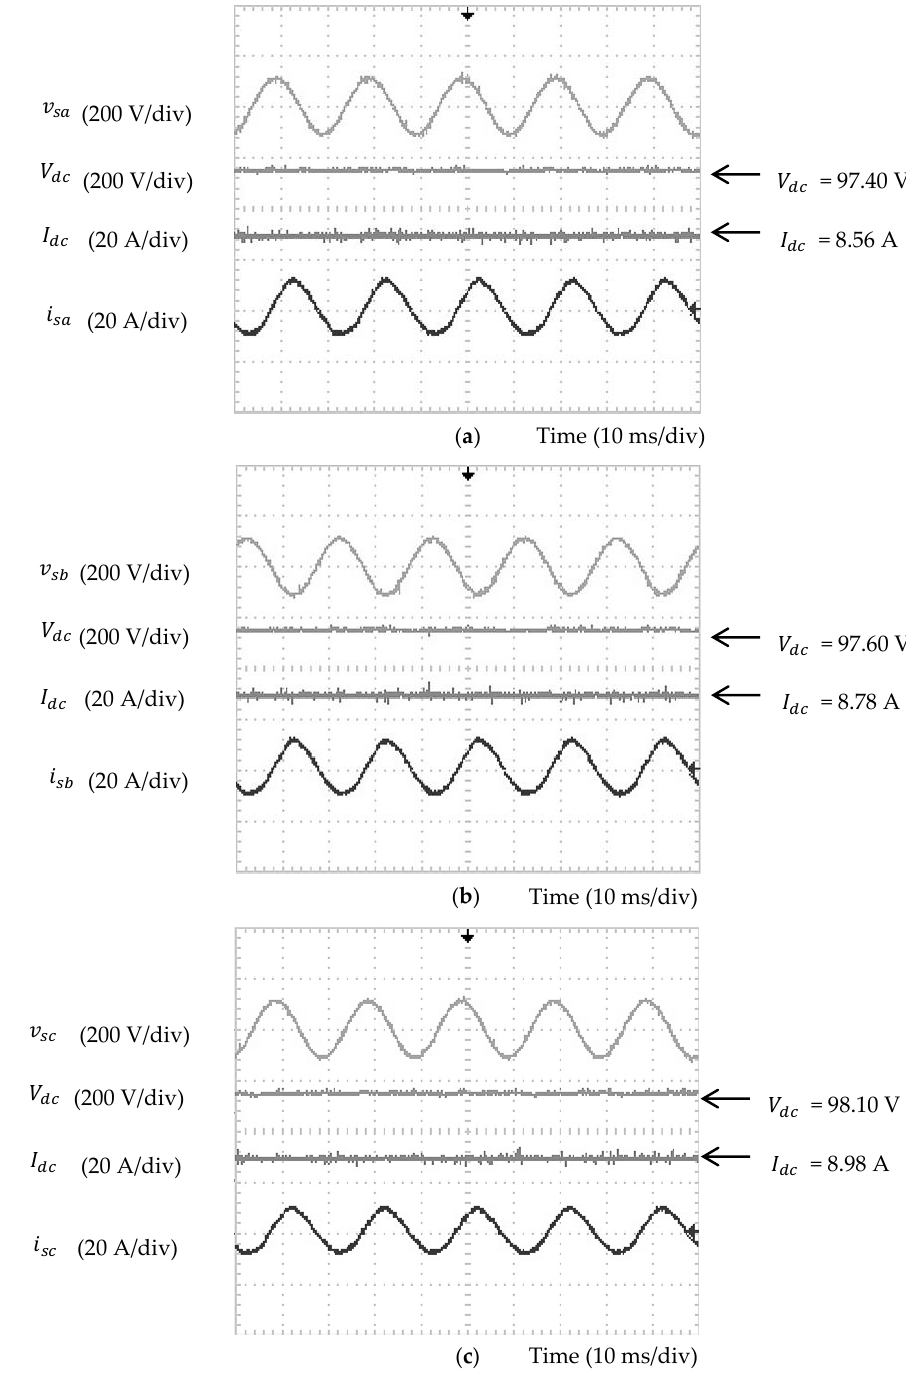
Figure 15. The input phase voltage, input phase current, output DC charging current, and output DC charging voltage provided by the charger: ( a ) Phase A, ( b ) Phase B, and ( c ) Phase C.